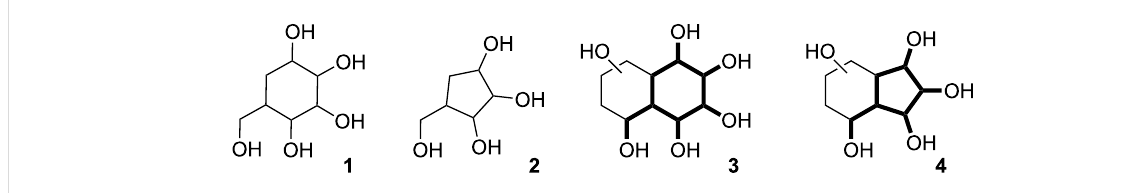
Figure 1: General structures of mono- and bicyclic